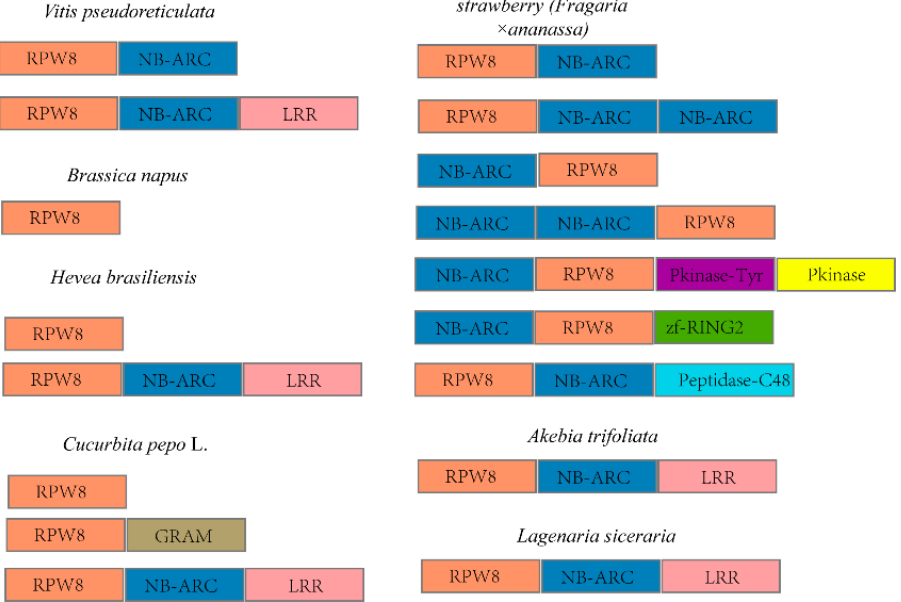
Figure 9. Various RPW8 proteins exist in plants. In Brassica napus , Akebia trifoliata and Lagenaria siceraria (Molina) Standl. , they only had one type of RPW8 fusion protein (RPW8 or RPW8-NR-ARC-LRR). In V. pseudoreticulata and H. brasiliensis , they had two types RPW8 fusion protein (RPW8/RPW8-NR-ARC, RPW8-NR-ARC-LRR). In Cucurbita pepo L., it had three types RPW8 fusion protein (RPW8, RPW8-GRAM, RPW8-NR-ARC-LRR). In strawberries , it had seven types RPW8 fusion protein (RPW8-NR-ARC, RPW8-(NB-ARC) 2 , NB-ARC-RPW8, (NB-ARC) 2 CC RPW8, RPW8-NB-ARC-CC-Pkinase_Tyr- Pkinase, NB-ARC- RPW8-zf-RING 2 , RPW8-CC-NB-ARC-Peptidase_C48). AtRPW8 was reported as a broad-spectrum resistance gene [39,40], expression of AtRPW8 leads to enhanced resistance to four Arabidopsis powdery mildew species, tobacco powdery mildew, Hyaloperonospora parasitica , Cauliflower mosaic virus , Pyricularia oryza , Xanthomonas oryzae pv. oryzae and other plant pathogens [30,65]. Homogeneously, the VpRPW8s could also enhance plant resistance to P. viticola , P. capsici , and P. parasitica [41]. Additionally, MdRNL2 and MdRNL6 (encode RPW8-NBS-LRR protein) were considered to be spectrum fungal resistance genes [66]. By transient expression in tobacco leaves and overexpression in Col-WT Arabidopsis , we showed that HbRPW8-a is a broad-spectrum resistance gene with resistance to E. cichoracearum UCSC1 and Pst DC3000. Overexpression of AtRPW8.1 and AtRPW8.2 can active oxygen burst and callose deposition and induce plant HR response, which promotes neoplastic pathogens Alternaria and Botrytis spp. infection. In contrast, overexpressing of HbRPW8-a could not increase the sensitivity of plants to neoplastic pathogens B.cinerea and P. capsici . However, further study is required to understand the different roles between HbRPW8-a and AtRPW8.1/AtRPW8.2. Plant RPW8s are diverse in terms of subcellular localization [41]. Both AtRPW8.1:YFP and AtRPW8.2:YFP appeared to be localized mainly in the endomembrane system [65], especially for AtRPW8.2:YFP, targeted to haustorium when powdery mildew infected, which is key to activation of resistance at the host-pathogen interface. BnHRa YFP and BnHRb-YFP were mainly localized to the extra-haustorial membrane [40]. VpRPW8s mainly located in the cytoplasm [41]. Interestingly, we found that HbRPW8-a was